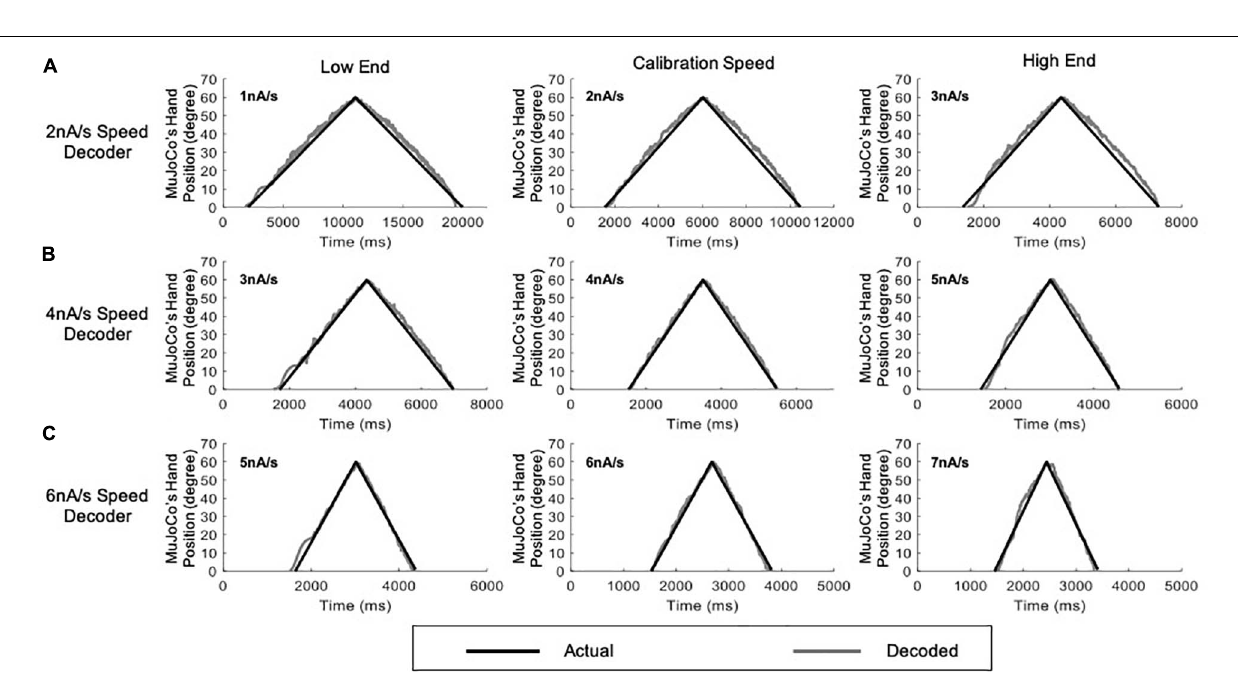
FIGURE 6 | Testing of the adaptive 3-speed decoder across a range of activation speeds. All figures include comparison of MuJoCo’s hand position when driven by the actual (black) vs. decoded (gray) inputs. (A) Decoder calibrated to 2 nA/s input tested on a 1 nA/s (low-end speed, left panel), 2 nA/s (calibration speed, middle panel), and 3 nA/s (high-end speed, right panel) inputs. (B) Decoder calibrated to 4 nA/s input tested on a 3 nA/s (low-end speed, left panel), 4 nA/s (calibration speed, middle panel), and 5 nA/s (high-end speed, right panel) inputs. (C) Decoder calibrated to 6 nA/s input tested on a 5 nA/s (low-end speed, left panel), 6 nA/s (calibration speed, middle panel), and 7 nA/s (high-end speed, right panel)